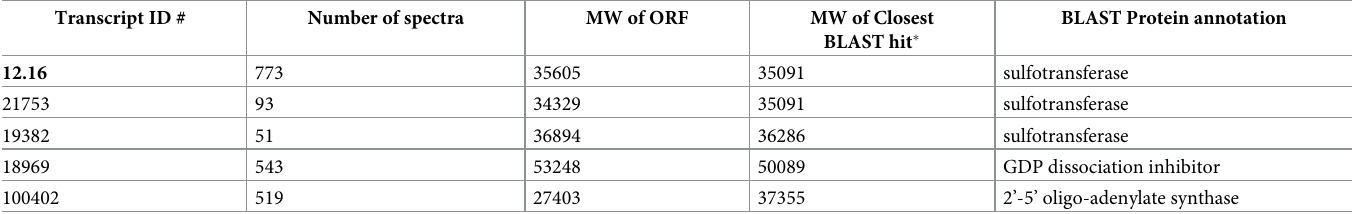
Table 1. Top 5 ORFs identified by